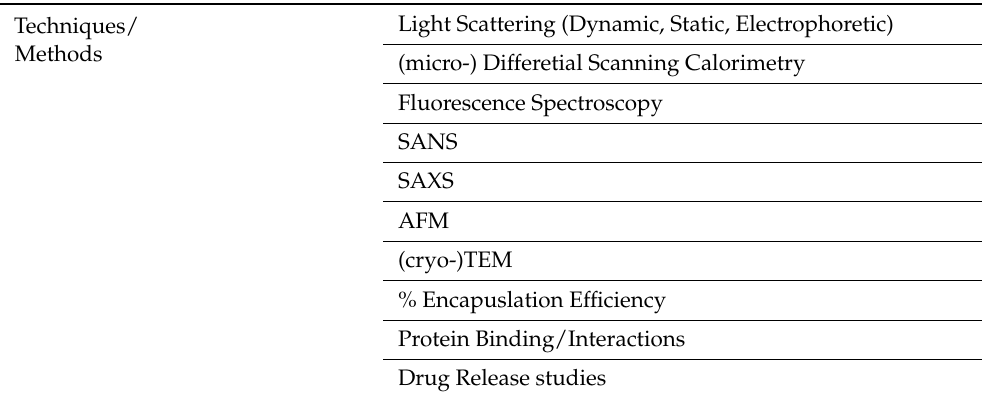
Table 1. Techniques and methods for characterization of PEO-PCL based nanoparticles and drug delivery